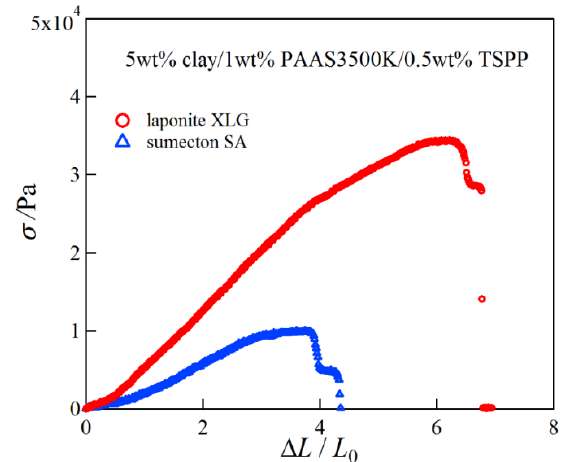
Figure 4. Pictures of a 5 wt % laponite/PAAS blend hydrogel (left) and a 5 wt % sumecton/PAAS blend hydrogel (right).